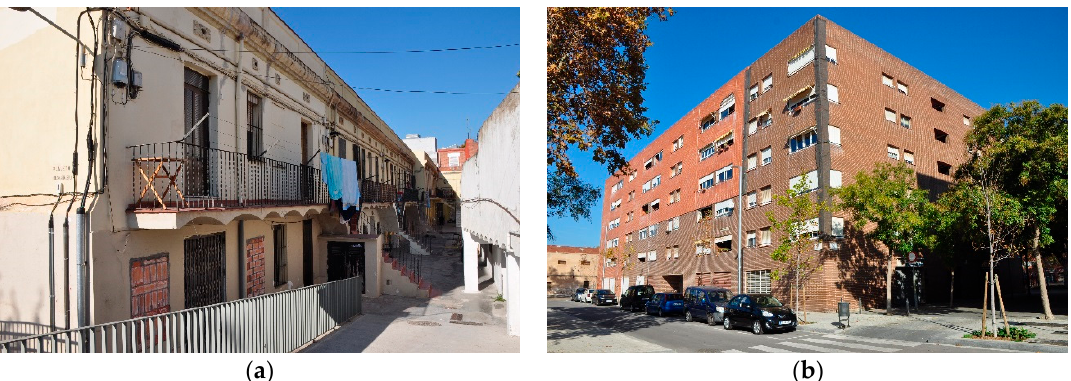
Figure 8. La Marina del Prat Vermell: ( a ) homes of the Bausili Colony, and ( b ) deterioration of modern buildings.